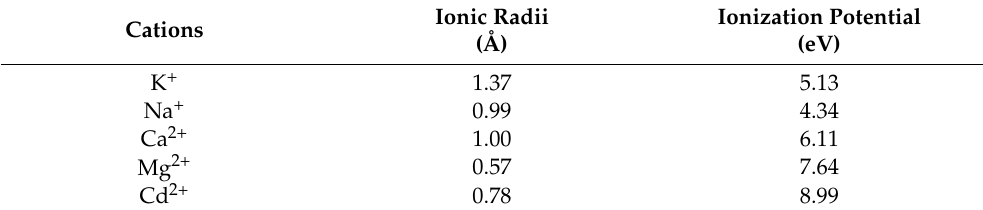
Table 3. Ionic radii and ionization potentials of exchangeable cations (after Lide